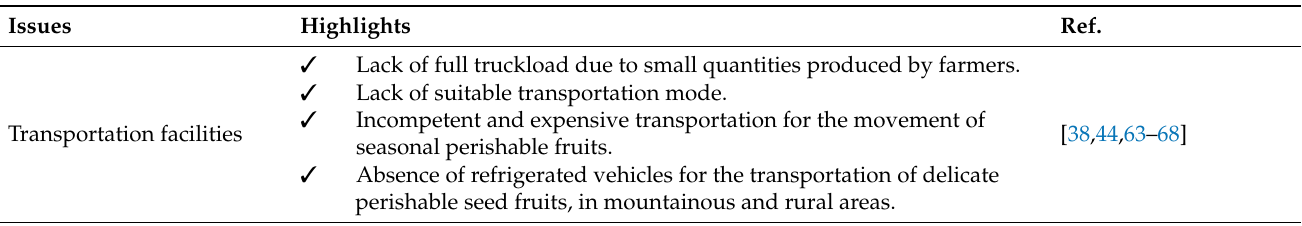
Table 7. Compiled transportation problems in the value chain of kiwi in Bageshwar District and strategies and solutions